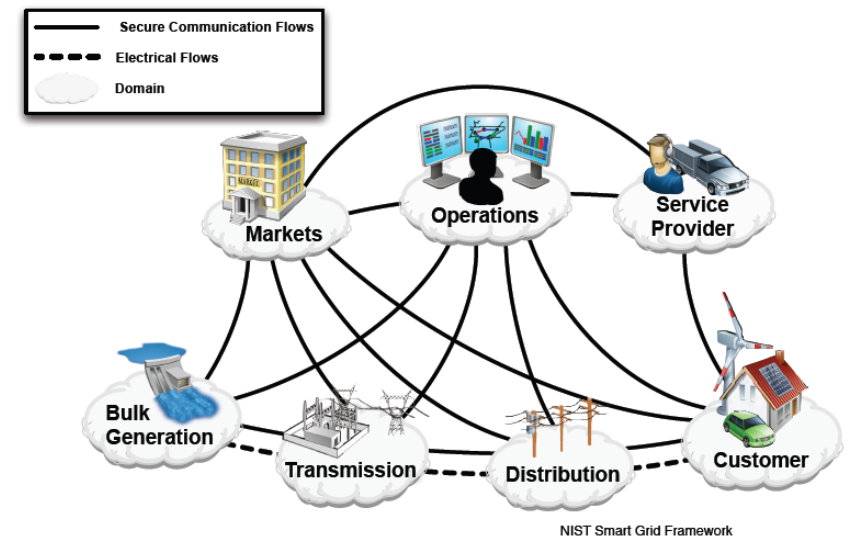
Figure 1. NIST Smart Grid conceptual model [12].